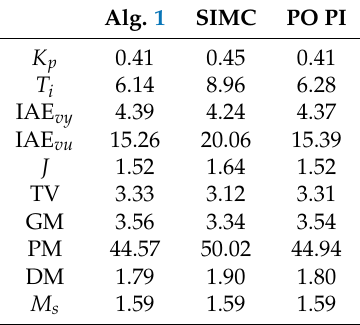
. The table shows s